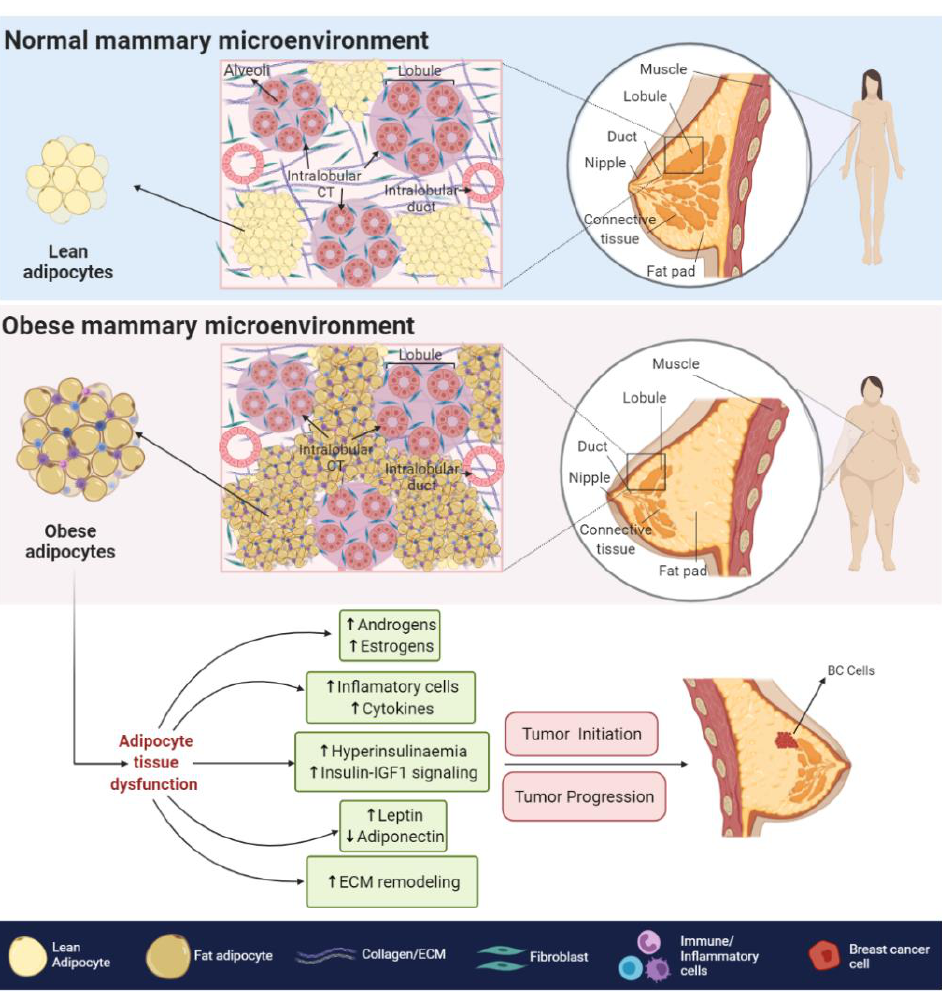
Figure 1. Normal vs. obese mammary microenvironment. Altered biological processes and production of ASFs are observed in obesity and are associated with BC development. CT—connective tissue; ECM—extracellular matrix.